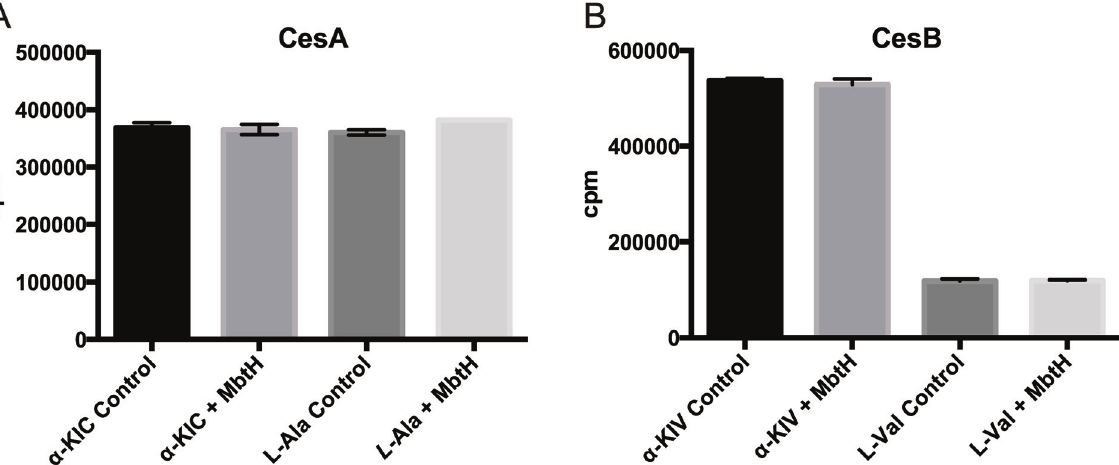
Fig 4. The MbtH-like protein of B . cereus does not affect the adenylation reactions of cereulide synthetase. The adenylation reaction of each A domain in CesA (A) and CesB (B) with the cognate substrate was evaluated by the ATP-PPi exchange assay at a single point of substrate, with or without MbtH in the reaction, in triplicate. Data is expressed in counts per minute (cpm).